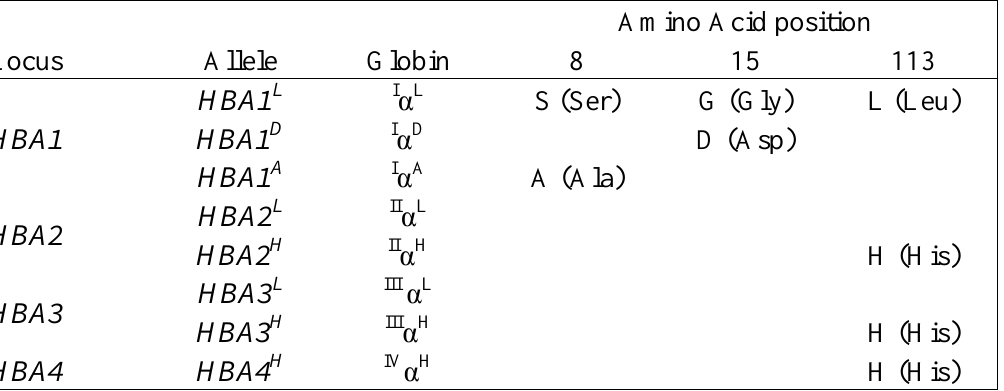
Table 4. Nomenclature of alpha globin genes and products, and amino acid exchanges involved in the different variants, referred to I α L globin in